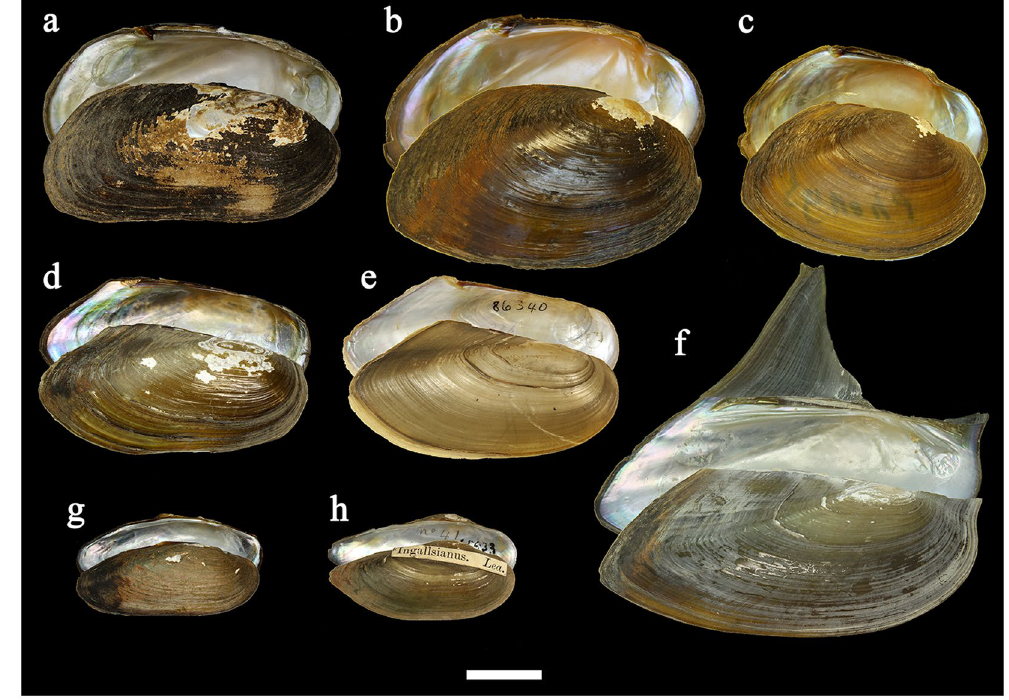
Figure 2. Shell shape variability within the two ancient radiations from the paleo-Mekong basin. ( a – e ) Pseudodontinae, including ( a ) Pseudodon aff. mouhotii sp.1, Nam Long River, Laos (RMBH biv182/19), ( b ) P . aff. vondembushianus sp.1, Phong River, Thailand (RMBH biv122/5), ( c ) P . cf. ellipticus , Phong River, Thailand (RMBH biv120/3), ( d ) Pilsbryoconcha cf. compressa , artificial pond near Ban Nhong Buen village, Thailand (RMBH biv116), ( e ) P. exilis , Thailand (USNHM 86340). ( f – h ) Rectidentini, including ( f ) Hyriopsis sp.2 , Chi River, Thailand (RMBH biv130), ( g ) Ensidens aff. sagittarius sp.2, artificial pond near Ban Nhong Buen village, Thailand (RMBH biv117), and ( h ) E. ingallsianus , Thailand (USNHM 85933). Scale bar = 2 cm (Photos: Ilya V.